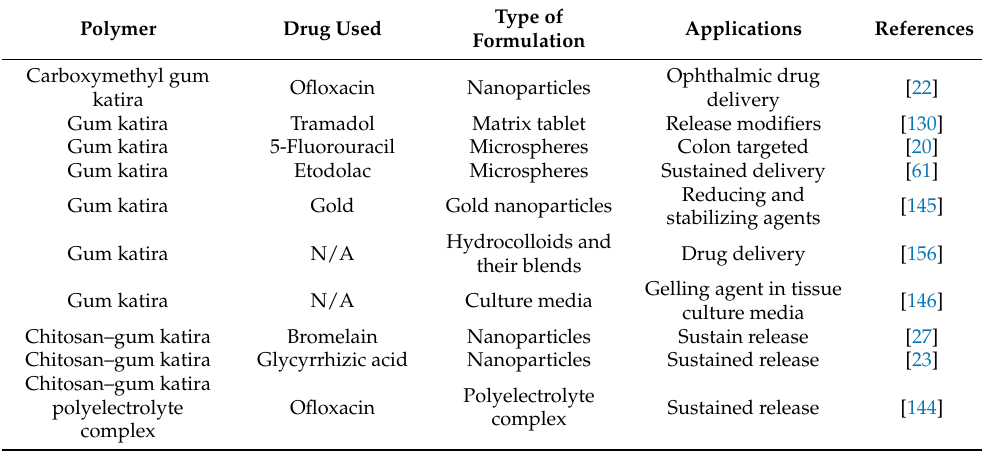
Table 2. Applications of gum katira and its